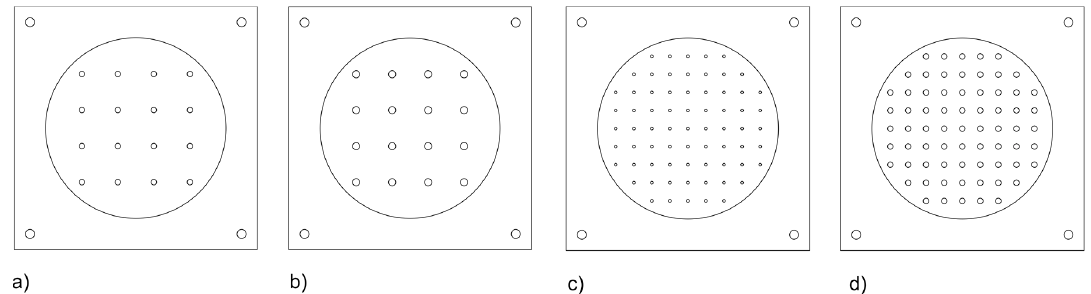
Figure 1. Different layout of the four perforated panels: ( a ) panel A; ( b ) panel B; ( c ) panel C; and, ( d ) panel D. Table 1. Summary of the characteristics of different panels under investigation. Panel ID Hole Diam. Spacing Hole